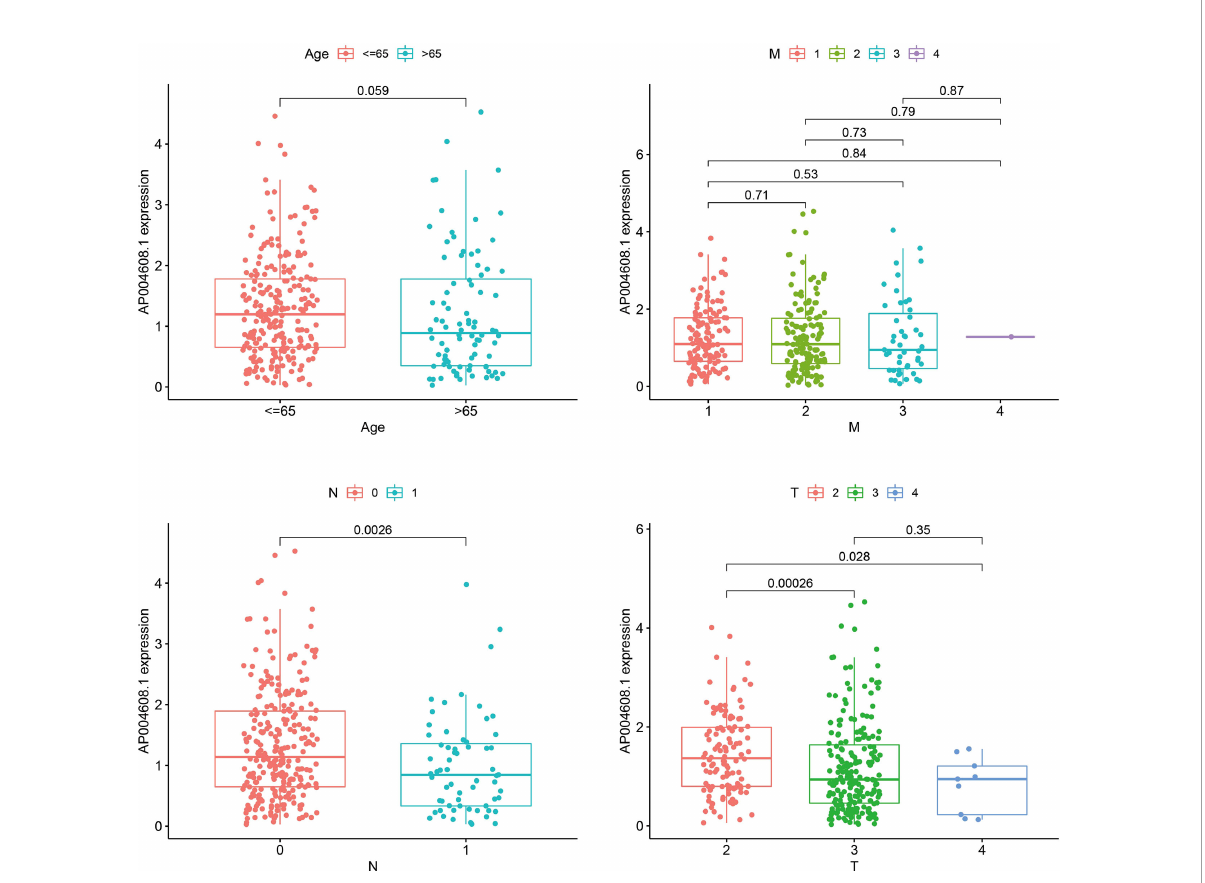
FIGURE 2 The correlation analysis of AP004608.1 expression and clinical indicators. The correlation analysis of AP004608.1 expression and Age, M stage, T stage, and N stage.